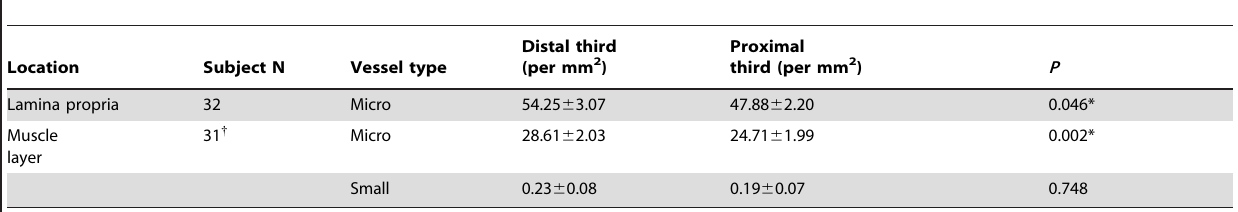
Table 2. Quantification of vaginal vessels according to location (alpha =0.05, two-tailed).